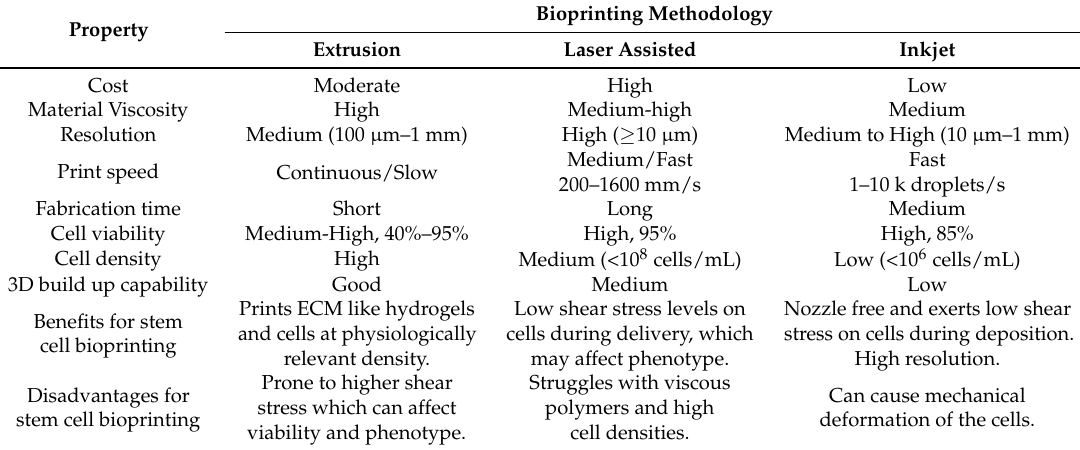
Table 1. A comparison of bioprinting methods. The table is a composite of bioprinting methodology comparison tables prepared from references